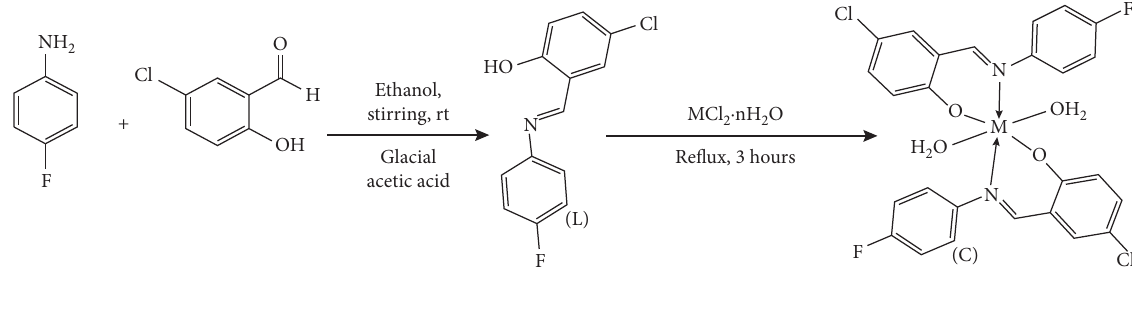
Scheme 1: Synthesis of Schiff base ligand metal (II)